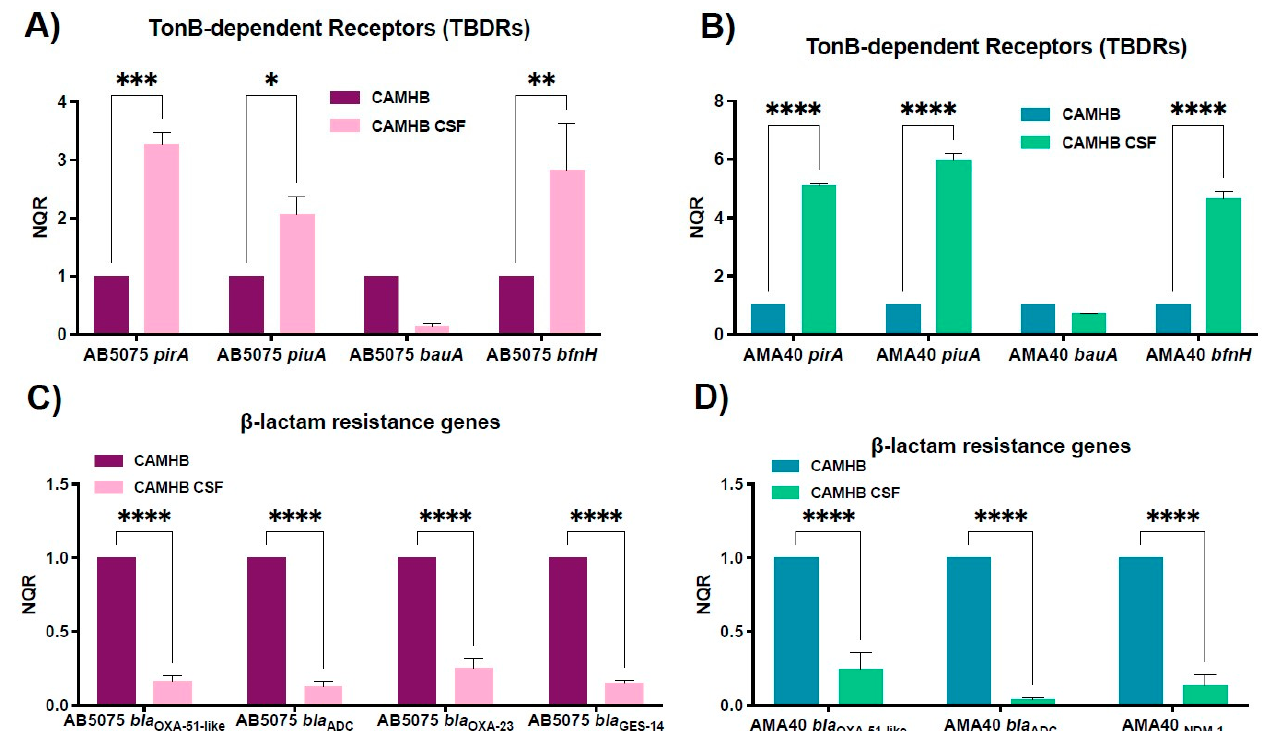
Figure 4. Expression analysis of iron uptake genes and genes coding for β -lactamases in the AB5075 ( A , C ) and AMA40 ( B , D ) strains. qRT-PCR of TonB-dependent receptors (pirA, piuA, bauA, and bfnH) and bla genes ( bla OXA-51-like , bla ADC , bla OXA-23 , bla NDM-1 , and bla GES-11 ) expressed in cation-adjusted Mueller Hinton (CAMHB) or CAMHB supplemented with cerebrospinal fluid (CSF). The data shown are the means ± SD of normalized relative quantities (NRQ) obtained from transcript levels calculated by the qBASE method. This method is a modification of the classic ΔΔ Ct method used to take multiple reference genes (in this work, rpoB and recA ) and gene-specific amplification efficiencies into account. At least three independent samples were used. CAMHB was used as the reference condition. Statistical significance ( p < 0.05) was determined by two-way ANOVA followed by Tukey’s multiple-comparison test, one asterisk: p < 0.05; two asterisks: p < 0.01; three asterisks: p < 0.001; and four asterisks: p < 0.0001.